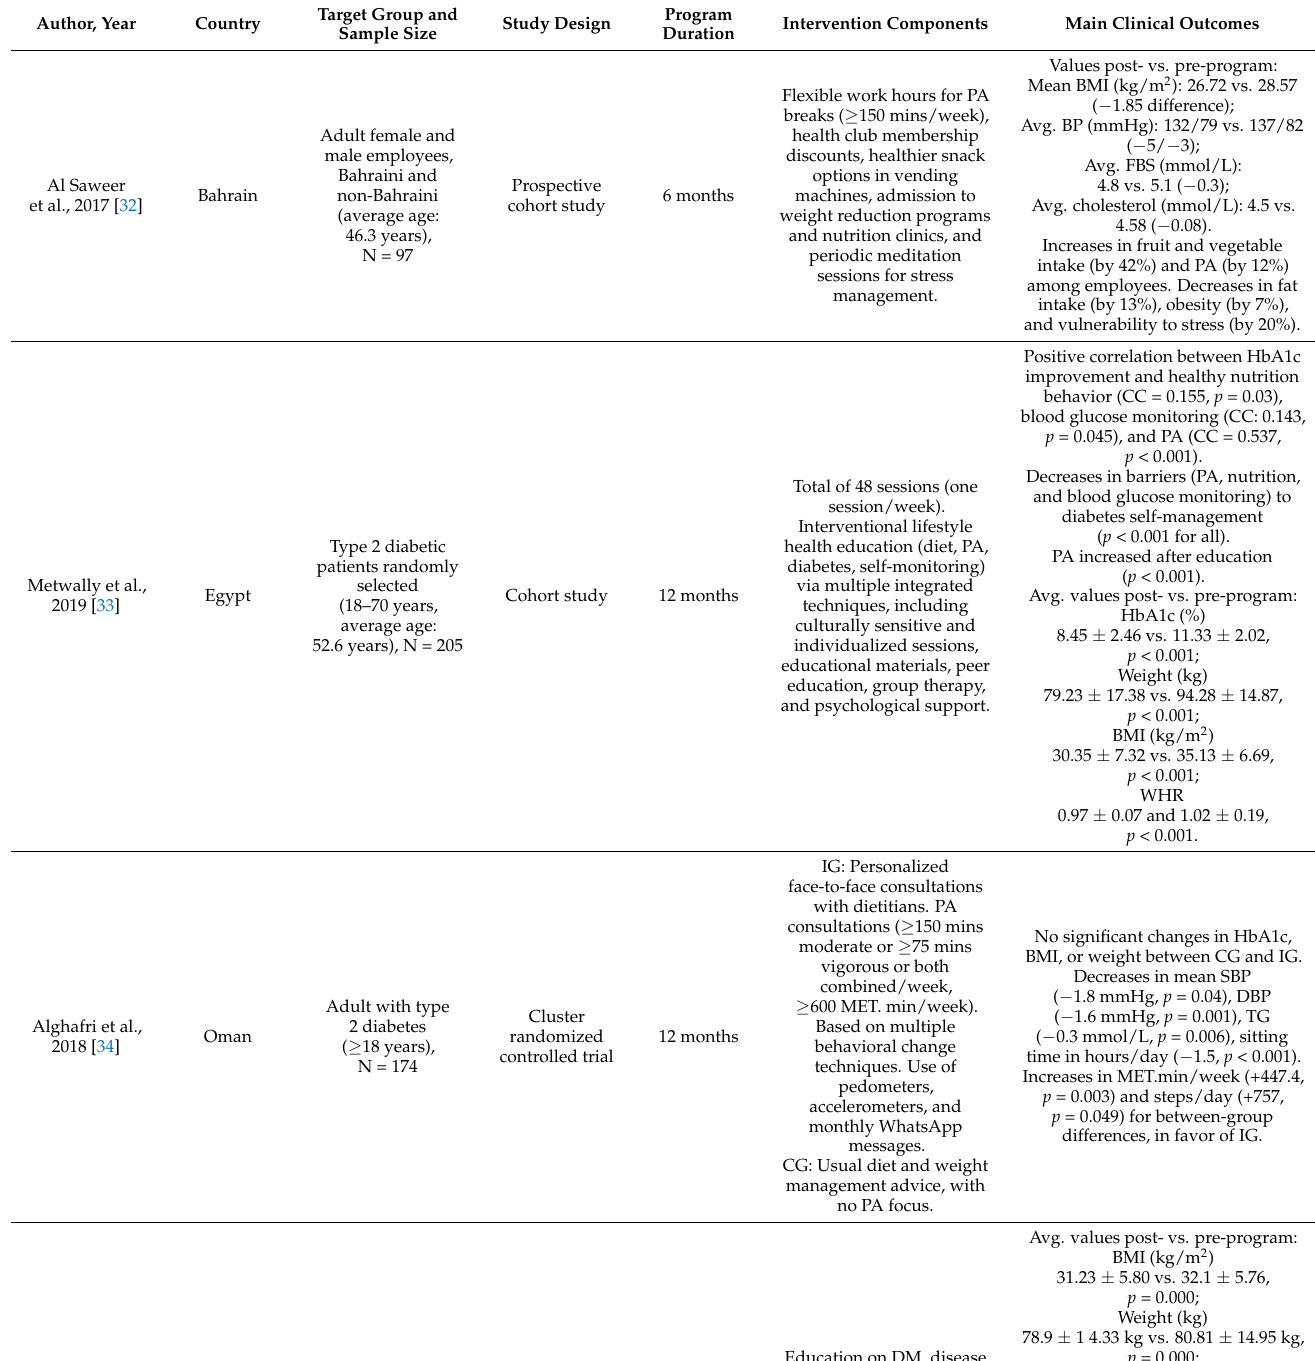
Table 1. Characteristics of lifestyle interventions in Arab countries ( n =